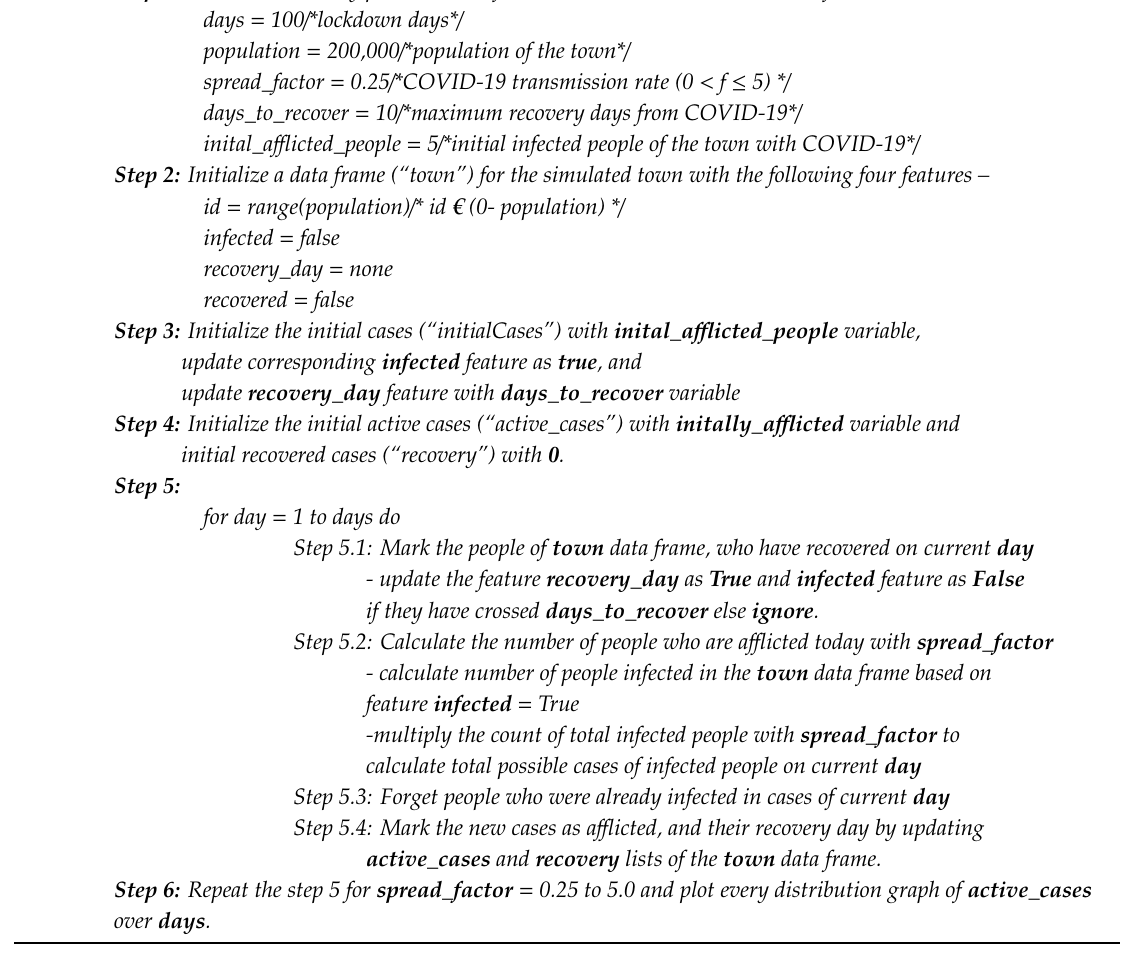
Algorithm 1. Importance of social distancing by flattening the curve of a ffl icted population over specific